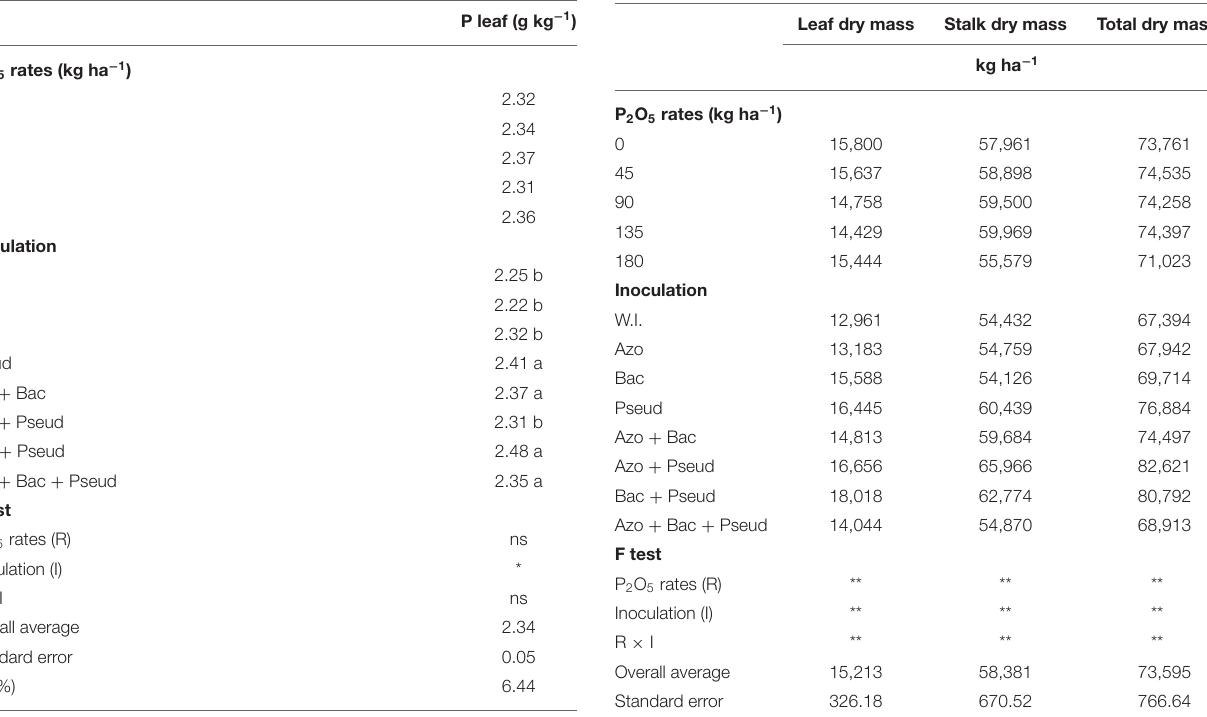
TABLE 4 | Leaf P contents as influenced by different P 2 O 5 doses and bacterial inoculations.